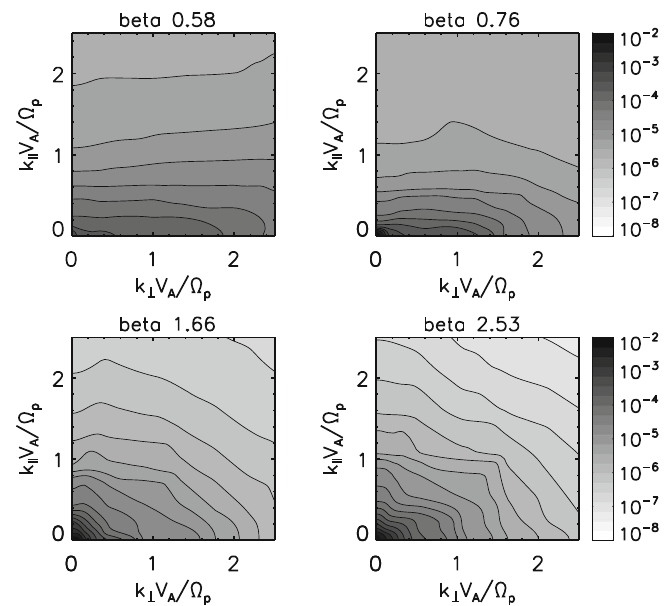
Fig. 17 Energy spectra in the wavevector domain for magnetic field fluctuations in the solar wind obtained from multi-point measurements using the Cluster spacecraft under various conditions of ion beta values. Image reproduced with permission from Narita et al. (2014), copyright by the